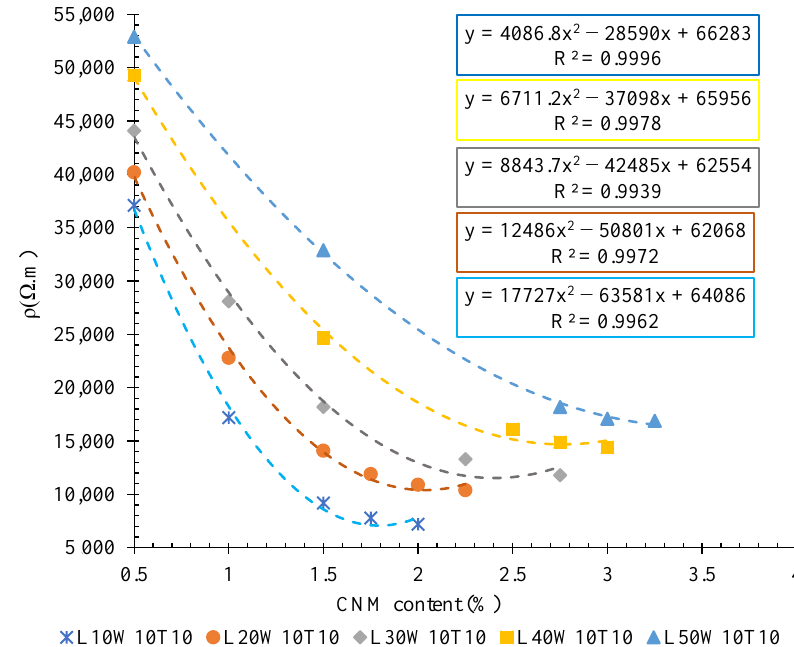
Figure 7. Volumetric electrical resistance of CNT/GNP-reinforced specimens with different lengths (surrounded between electrodes).